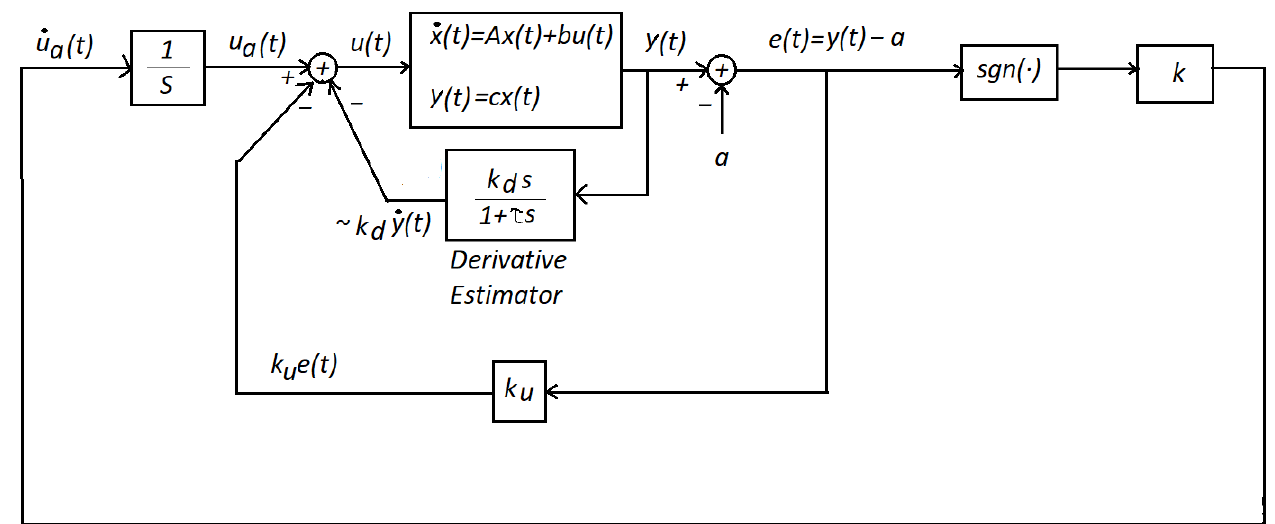
Figure 3. A recent control scheme using a dynamic optimizer. The parameter τ in the derivative estimator block was assumed to be small. This is a well-known derivative block (see, for instance, reference [25], p.